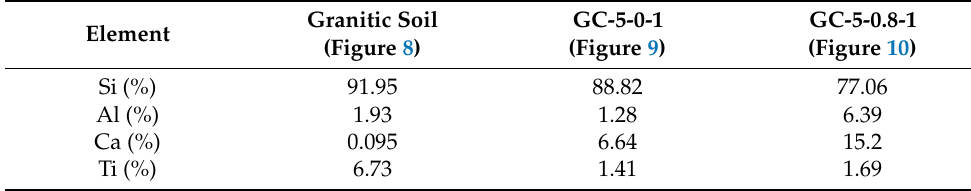
Table 7. Initial condition of the wetting–drying samples.